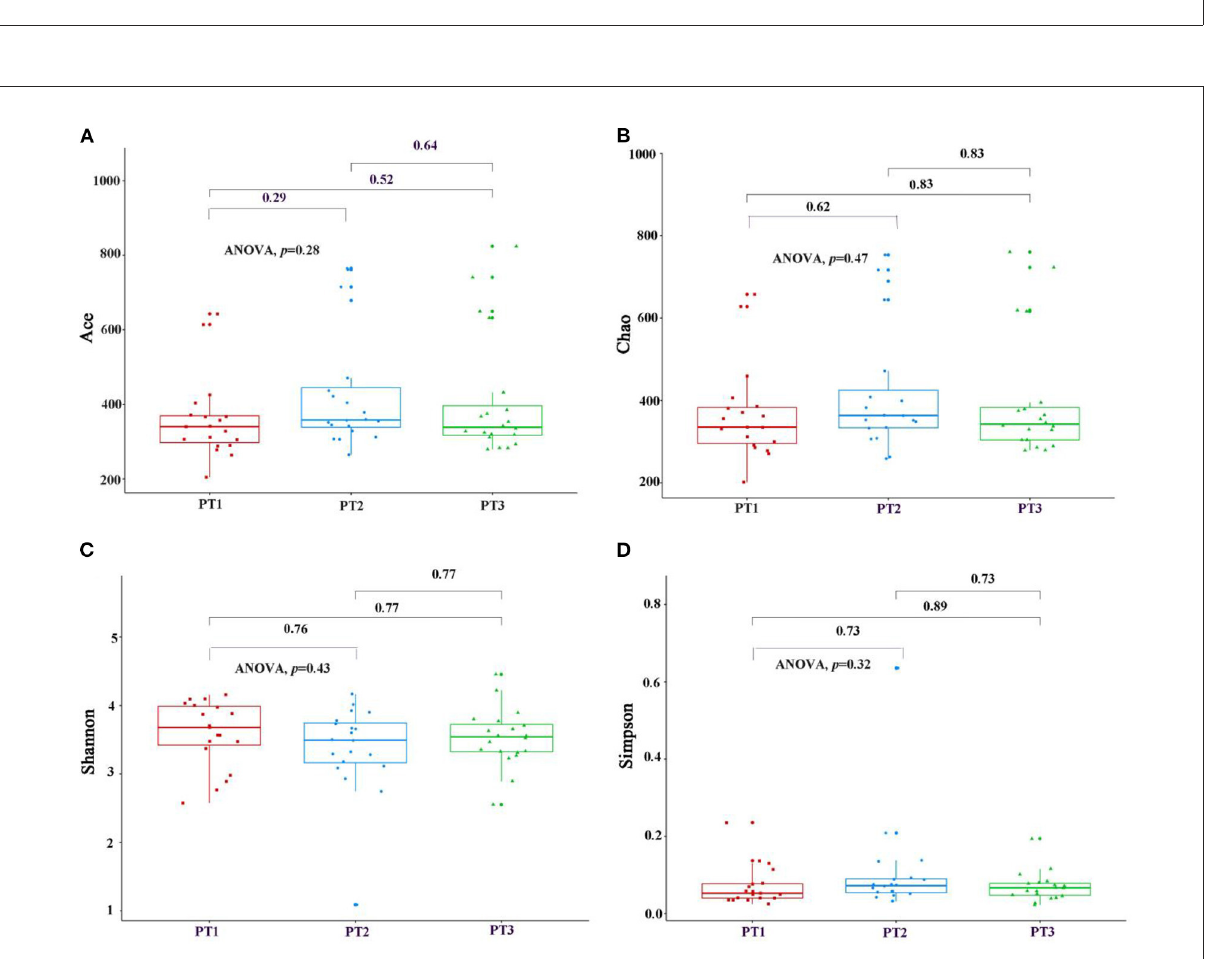
FIGURE3 The oral microbial α -diversity, as assessed with ACE (A) , Chao (B) , Shannon (C) , and Simpson (D) indexes among three groups. PT1 (tertile 1) means the oral microbiomes of the most anti-inflammatory diet group, PT2 (tertile 2) means the oral microbiomes of the no anti-inflammatory/pro-inflammatory diet group, and PT3 (tertile 3) means the oral microbiomes of the most pro-inflammatory diet